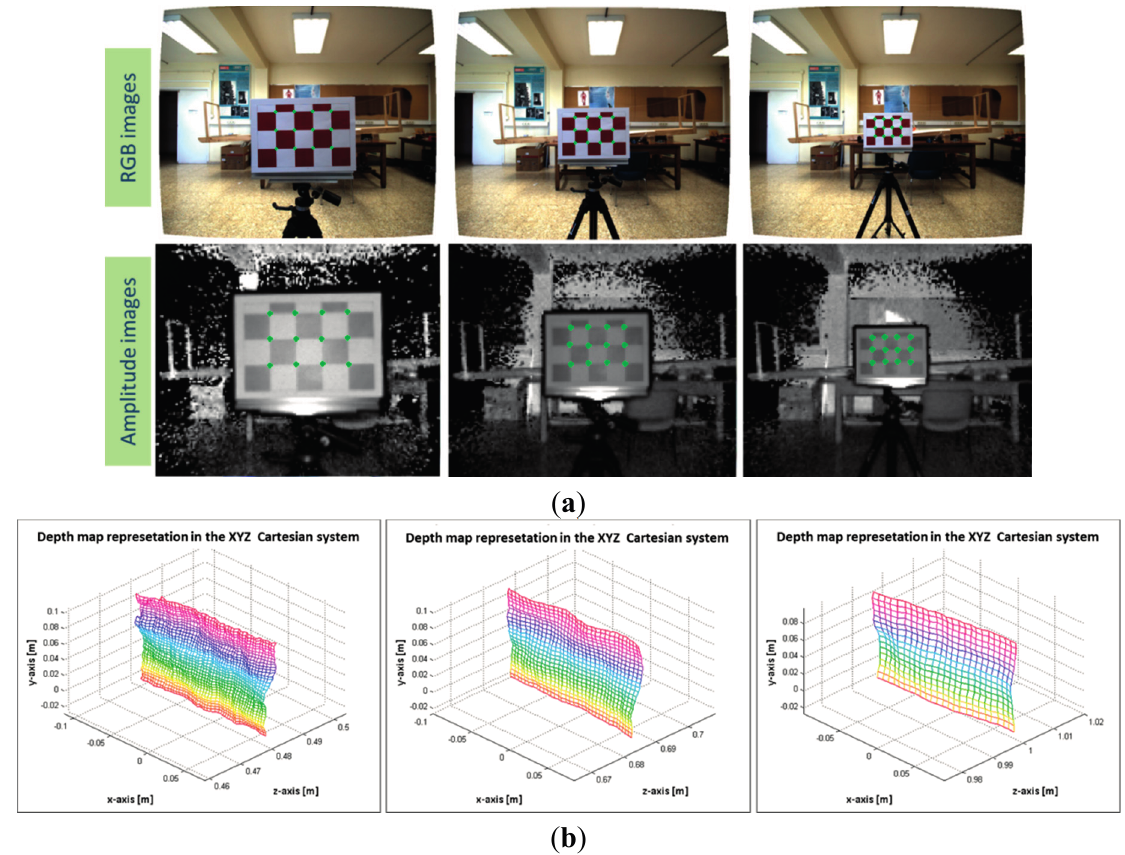
Figure 5. Samples of images pair of the pattern grid board. ( a ) RGB and ToF amplitude images; ( b ) the depth map representation in the Cartesian system of the inner 2 × 3